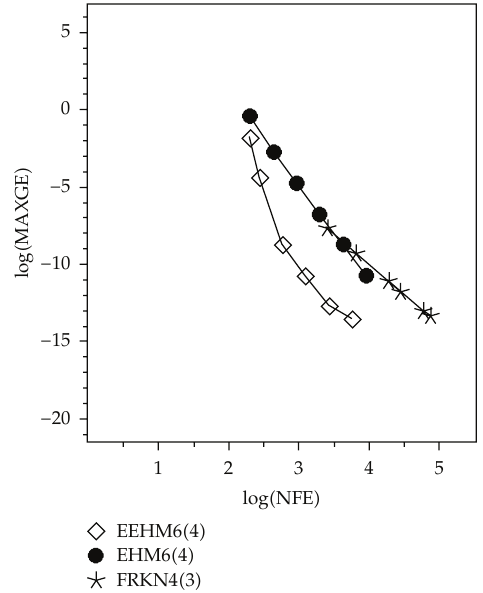
Figure 3: E ffi ciency curves for Problem